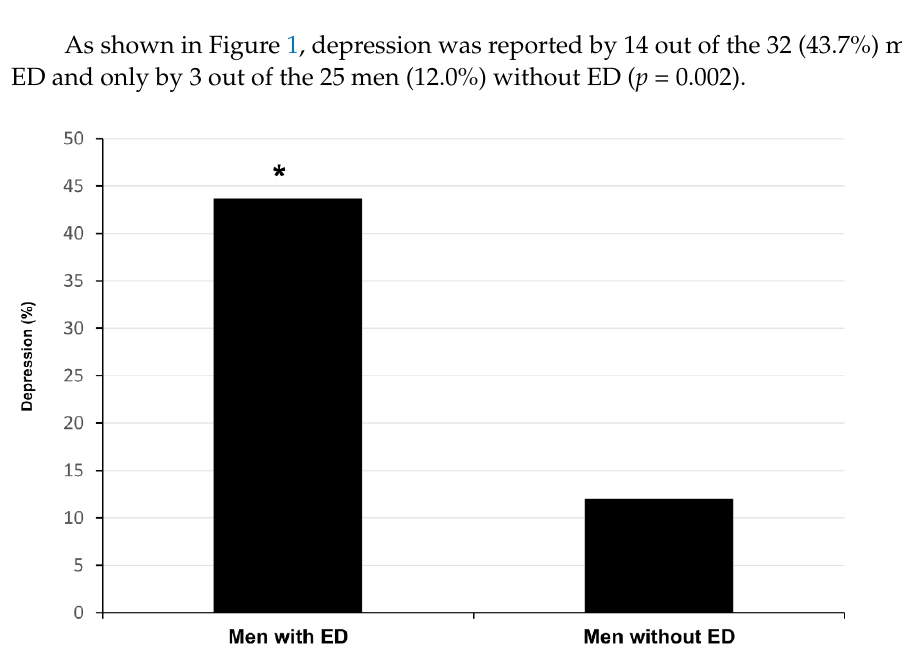
Figure 1. Percentage of spinal cord injured, depressed men with and without erectile dysfunction (ED). * p = 0.002.